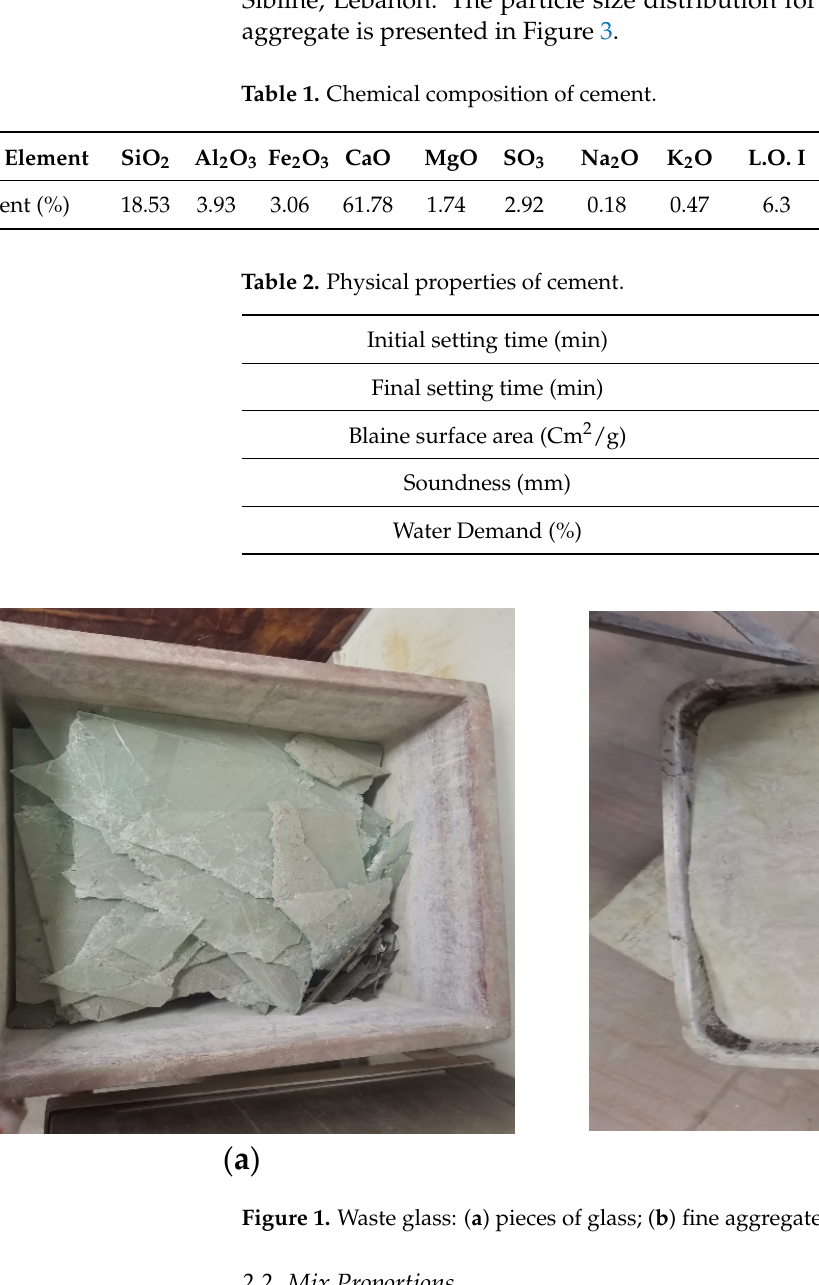
Figure 2. Treated PA fi bers with NaOH solution.